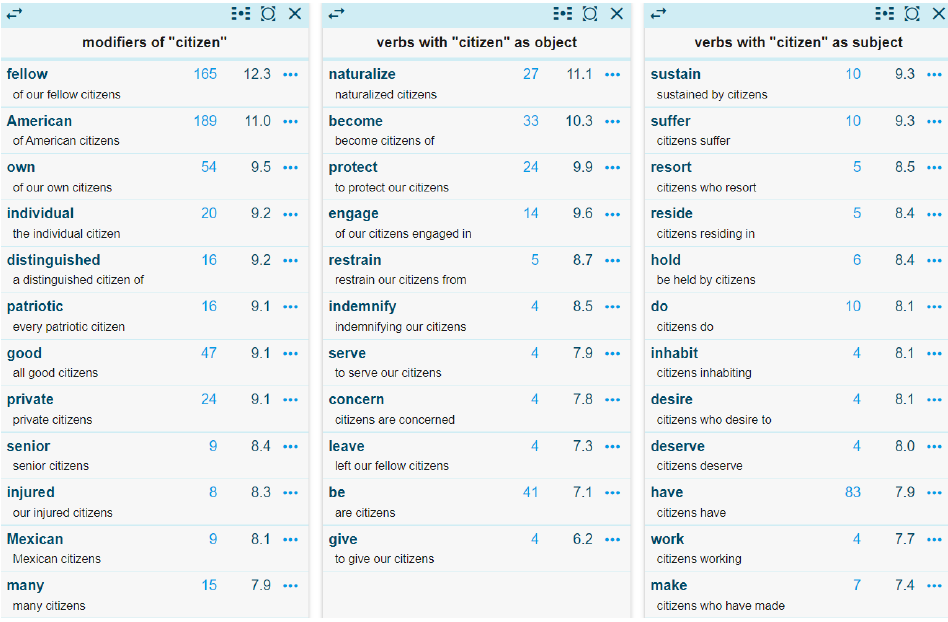
Figure 3. Word-sketch of citizens in the SoU